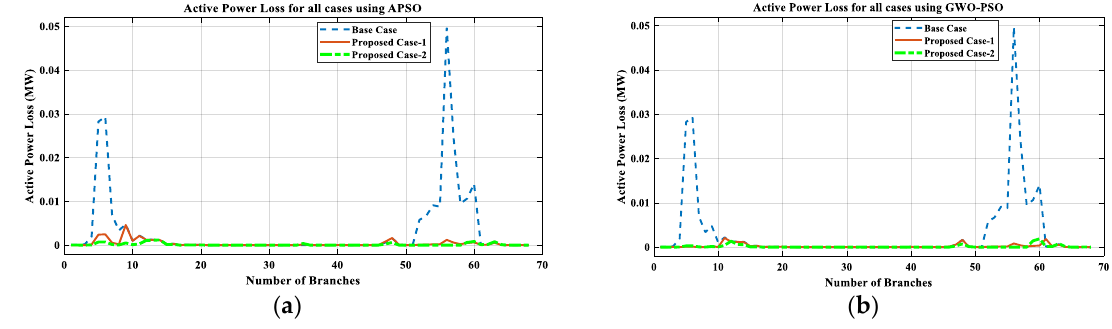
Figure 21. Real power loss for all cases of 69-bus RDN; ( a ) APSO, ( b ) GWO-PSO.